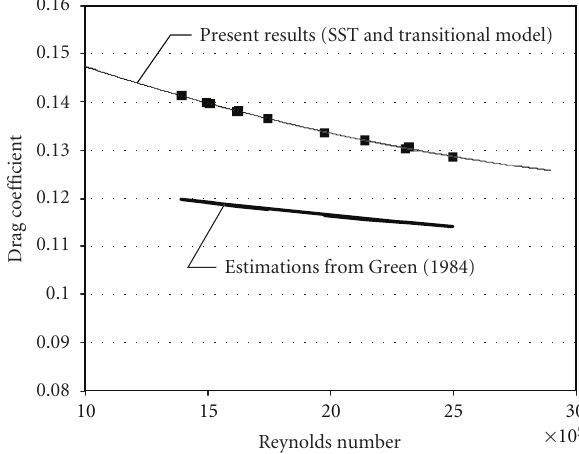
Figure 3: Drag coe ffi cients for Class II probes, including SST model and transitional model results as well as drag coe ffi cients from Green